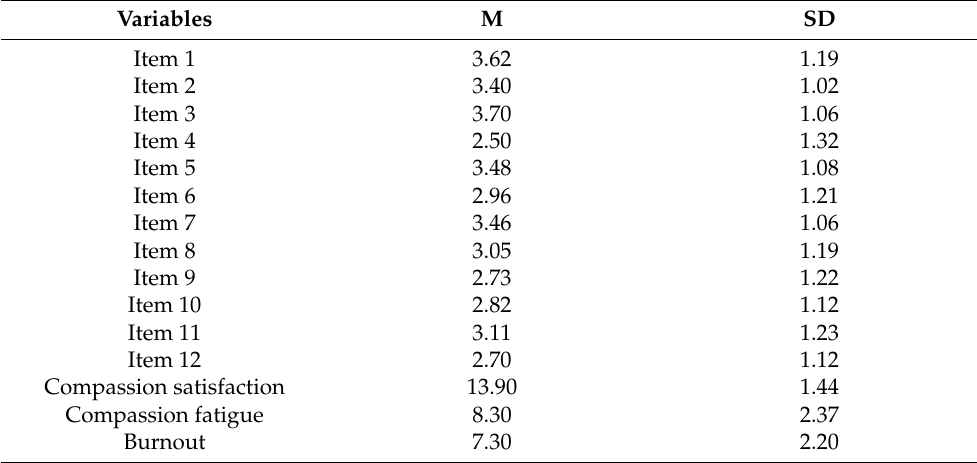
Table 2. Descriptive statistics for self-compassion in the different subgroups.